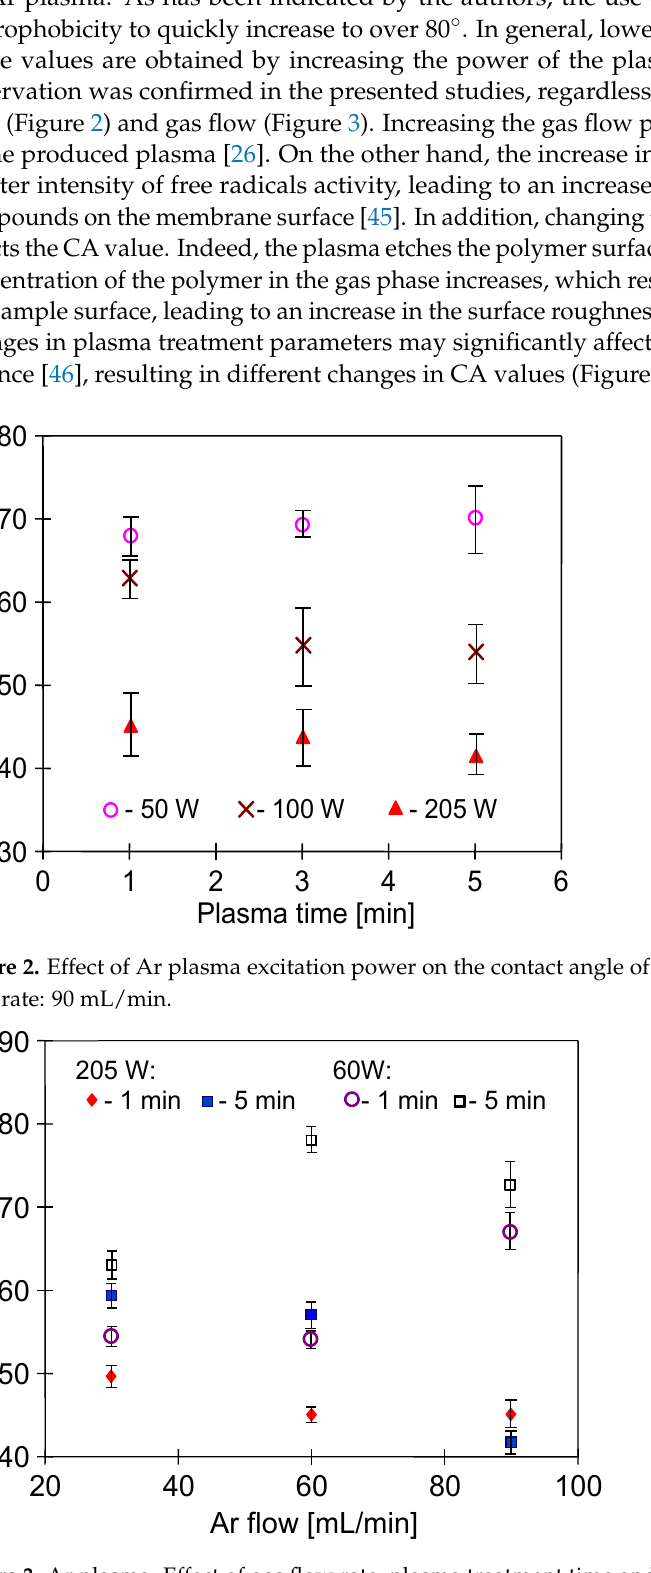
Figure 3. Ar plasma. Effect of gas flow rate, plasma treatment time and power on the contact angle of PP foil.